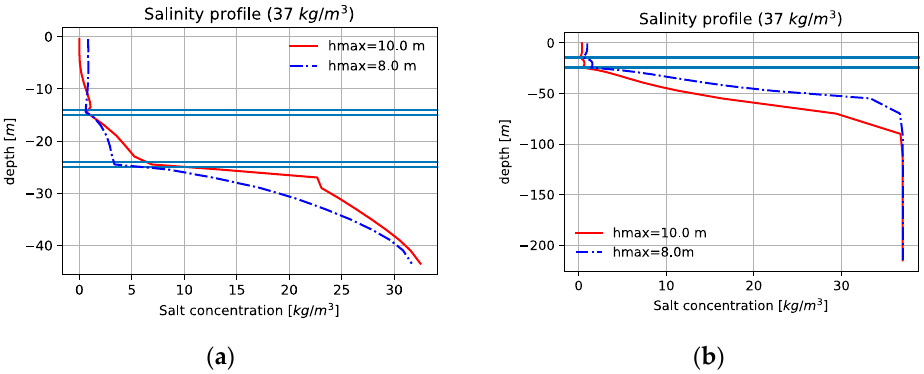
Figure 14. Differences between the salinity profile and wedge intrusion as a function of the depth with a constant-head equal to 10.0 m (red line) and 8.0 m (blue line) for an aquifer of: ( a ) − 45 m a.s.l.; ( b ) − 220 m a.s.l. Notice the presence of the two steps-shape in both scenarios.